Question: Describe this figure in one sentence.
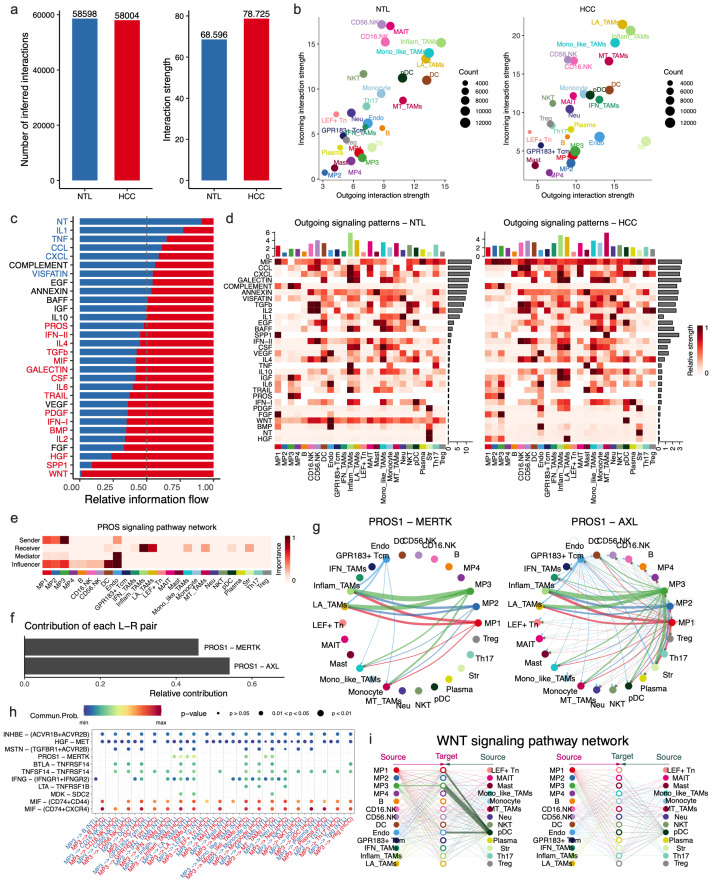
Answer: Cell communication network analysis reveals signal transduction remodeling in HCC microenvironment. (A) Quantitative comparison of cell communication networks between tumor and normal groups, including the analysis of the number of signaling pathways and signal strength. (B) Scatter plot showing the incoming and outgoing signal strength of cell subtypes in tumor and normal groups, illustrating the roles of each subtype in the signaling network. (C) Comparative analysis of relative information flow for each signaling pathway between tumor and normal groups. (D) Heatmap displaying the outgoing signal strength of different cell types in tumor and normal groups. (E) Network localization and functional identification of cell types involved in the PROS signaling pathway. (F) Contribution analysis of key receptor-ligand pairs in the PROS signaling pathway. (G) Circular plot showing the involvement and signal strength of each cell type in specific receptor-ligand signaling pathways. (H) Bubble plot of receptor-ligand pairs specifically activated in the tumor group compared to the normal group, with MP3 as the signal source. (I) Signal network analysis of cell types involved in the WNT signaling pathway.